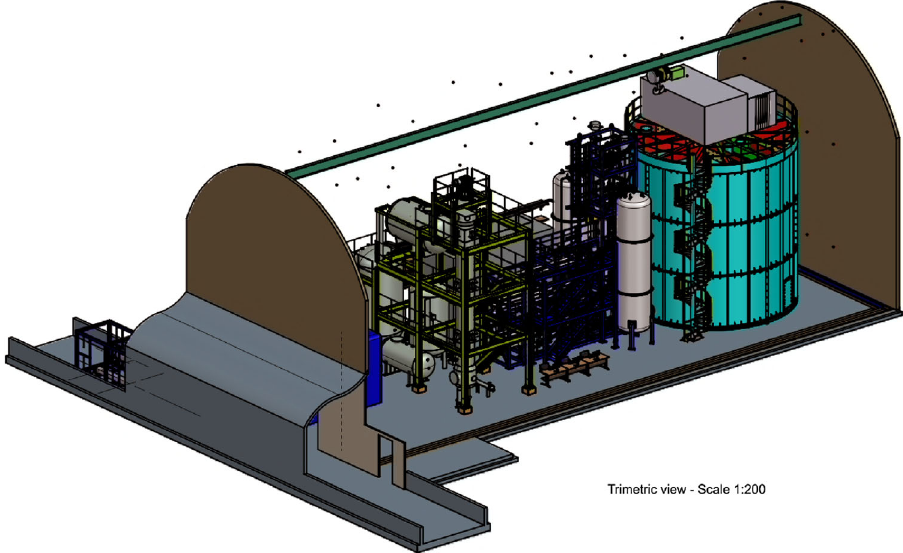
Fig. 23 Isoview of the underground Liquid Scintillator Hall. OSIRIS is located at the back of the hall, next to the Stripping